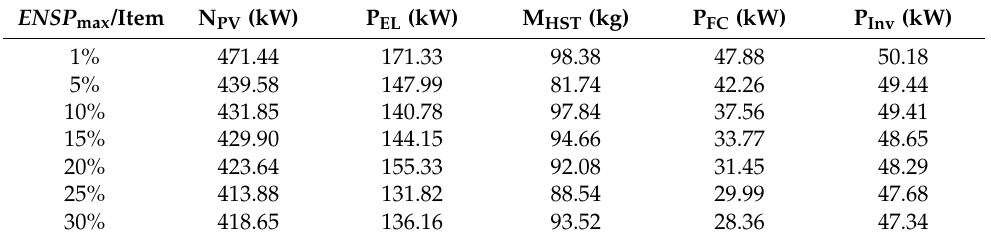
Table 8. Sizing results of HPV/FC energy systems using the IAEO, considering different ENSP max .